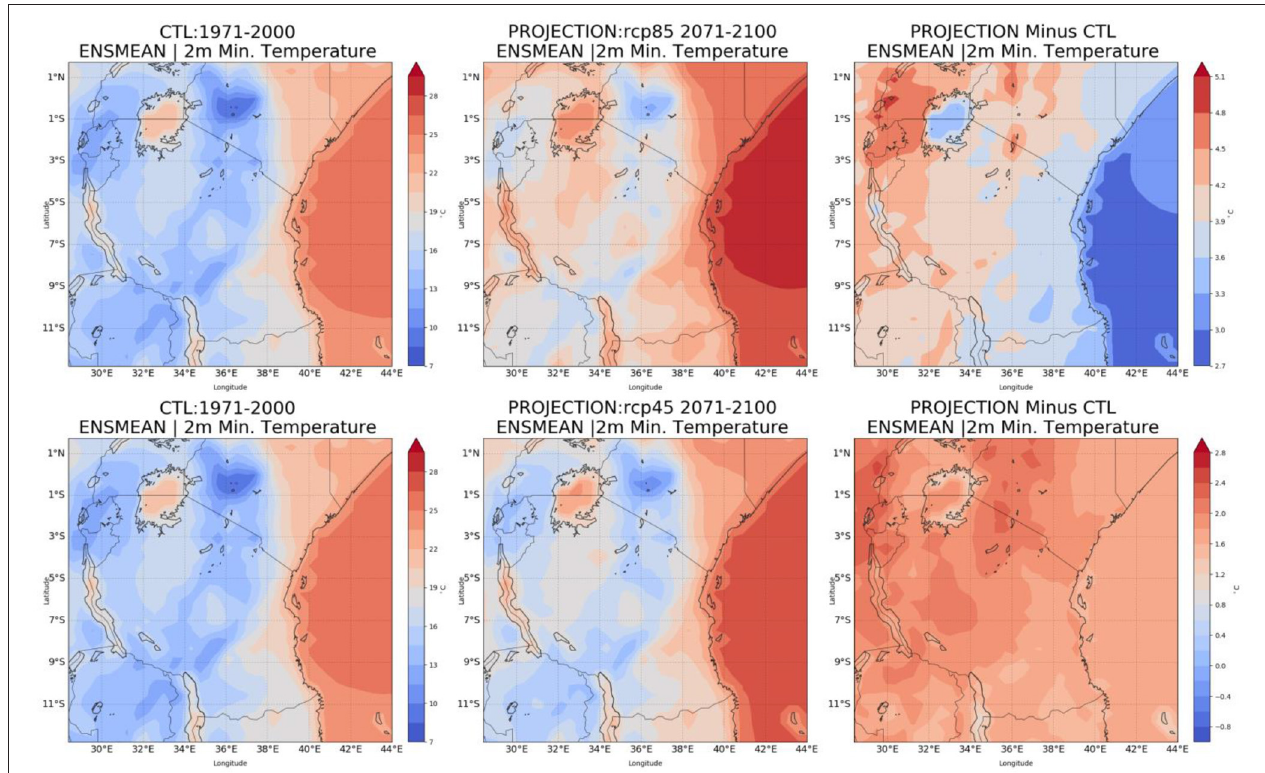
FIGURE 8 | The average of minimum temperature during base period (1971–2000), end century (2071–2100), and the change in temperature during end century under both RCP8.5 (upper) and RCP 4.5 (lower) .